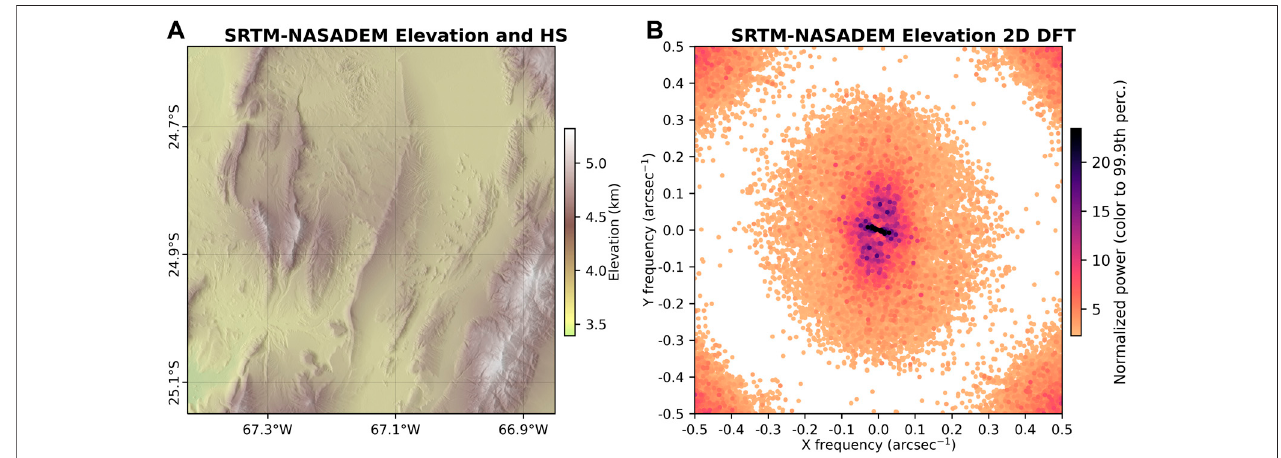
FIGURE 9 | 2D DFT analysis of elevation in the same 1 arcsec ∼ 60-km square tile as Figure 4 . (A) SRTM-NASADEM hillshade and elevation. (B) 2D DFT periodogram, showing the normalized amplitude (power) in frequency space. As in Figure 4 , for visualization purposes the 2D DFT was morphologically dilated to increase the size of the discrete, high power peaks and values below the 50th percentile were excluded (colored white). Without a local detrending procedure to accentuateinter-pixelconsistency(e.g., HPHS )topographicsignalsbecomemoreprominent,andtheartifactpeaksandhigh-frequencyvariancearereducedand/ or obscured. In this example, the approximately north-south trending ridges create the highest power signals in (B)